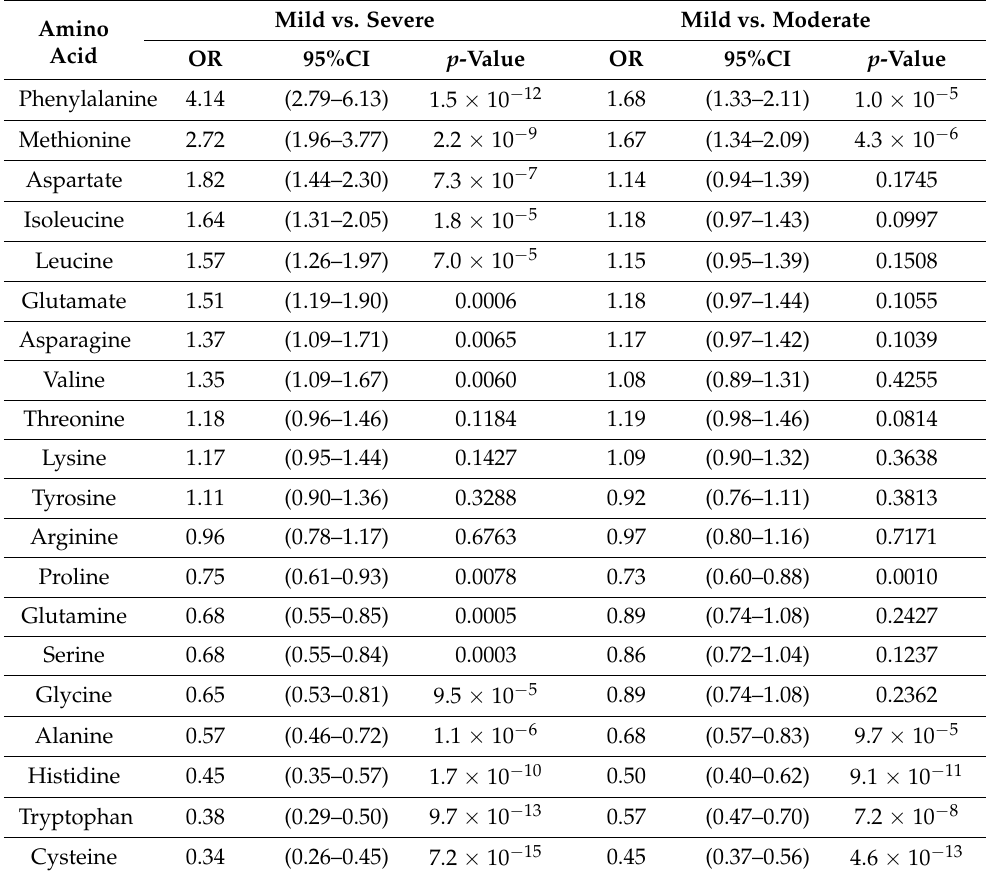
Table 2. Univariate association between circulating-amino-acid levels and the odds of presenting mild vs. severe and moderate COVID-19